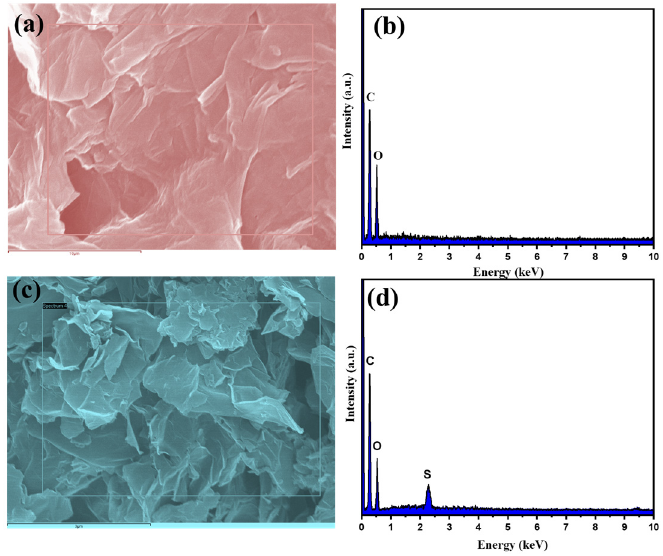
Figure 3. EDX image ( a ) and spectrum ( b ) of GO. EDX image ( c ) and spectrum ( d ) of S@rGO.